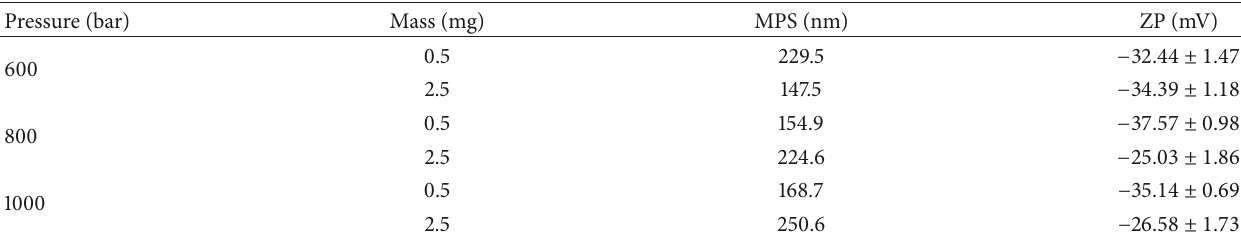
Table 6: Preparation of HCPTNPs with ASS by